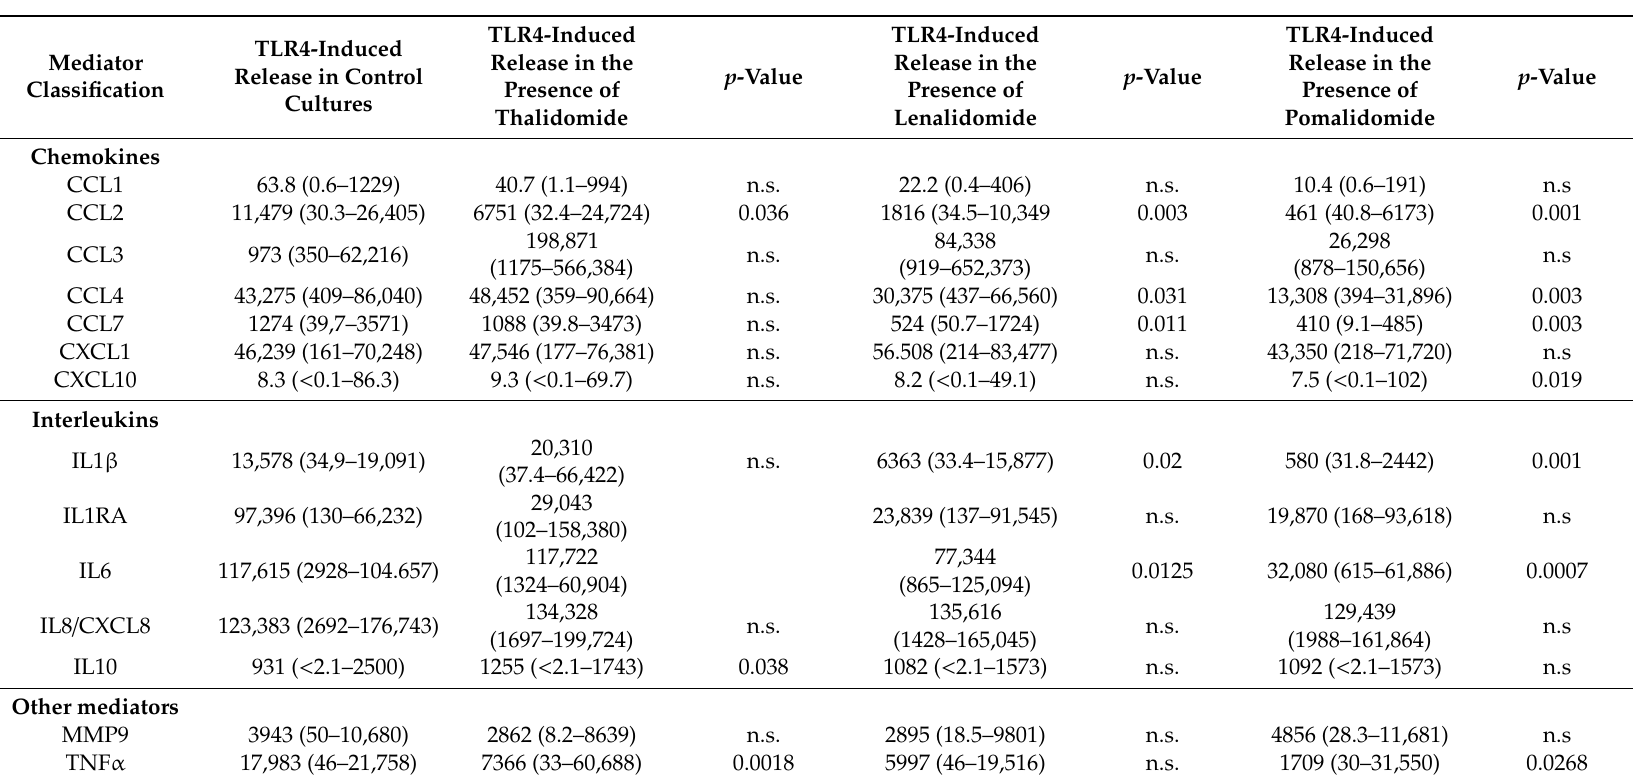
Table 1. The e ff ects of thalidomide, lenalidomide, and pomalidomide on TLR (Toll like receptor) 4 -induced release of soluble mediators by normal monocytes derived from healthy individuals. The data are presented as the median and range of the levels detected in culture supernatants. Fifteen healthy individuals were examined. The Wilcoxon test for paired samples was used for the statistical analyses (n.s., not significant). Unless otherwise stated all concentrations are given as pg /